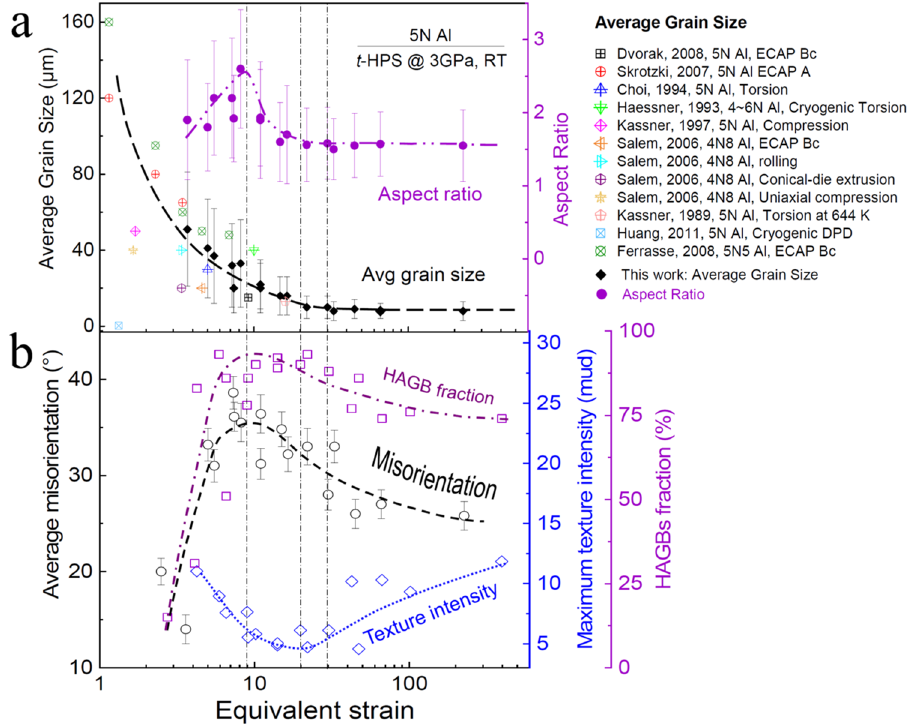
Figure 7. Evolution of microstructure parameters: ( a ) average grain sizes and grain aspect ratios; ( b ) average grain boundary misorientation, HAGB fractions and intensity of { figure, upon increase of t -HPS equivalent strain: grain size data from the literature 36,51–58 are also